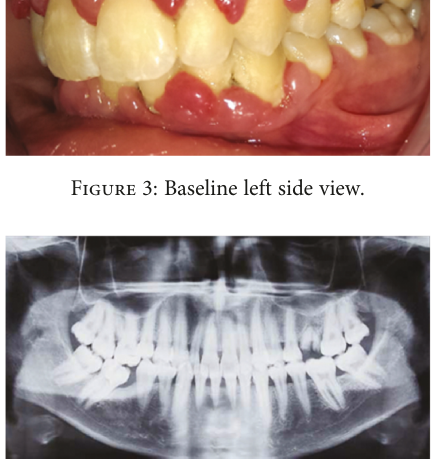
Figure 4: Baseline radiographic